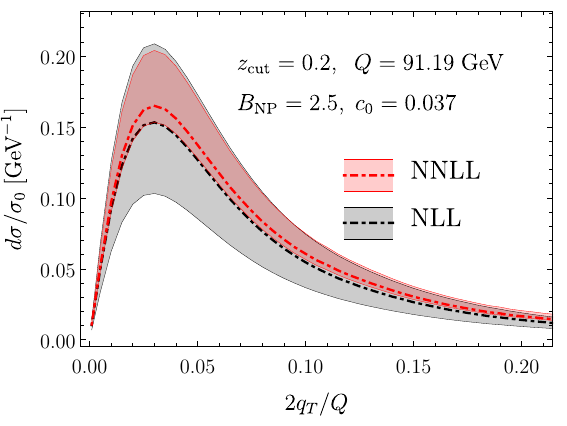
Figure 6 . Transverse momentum de-correlation for e + e the Z